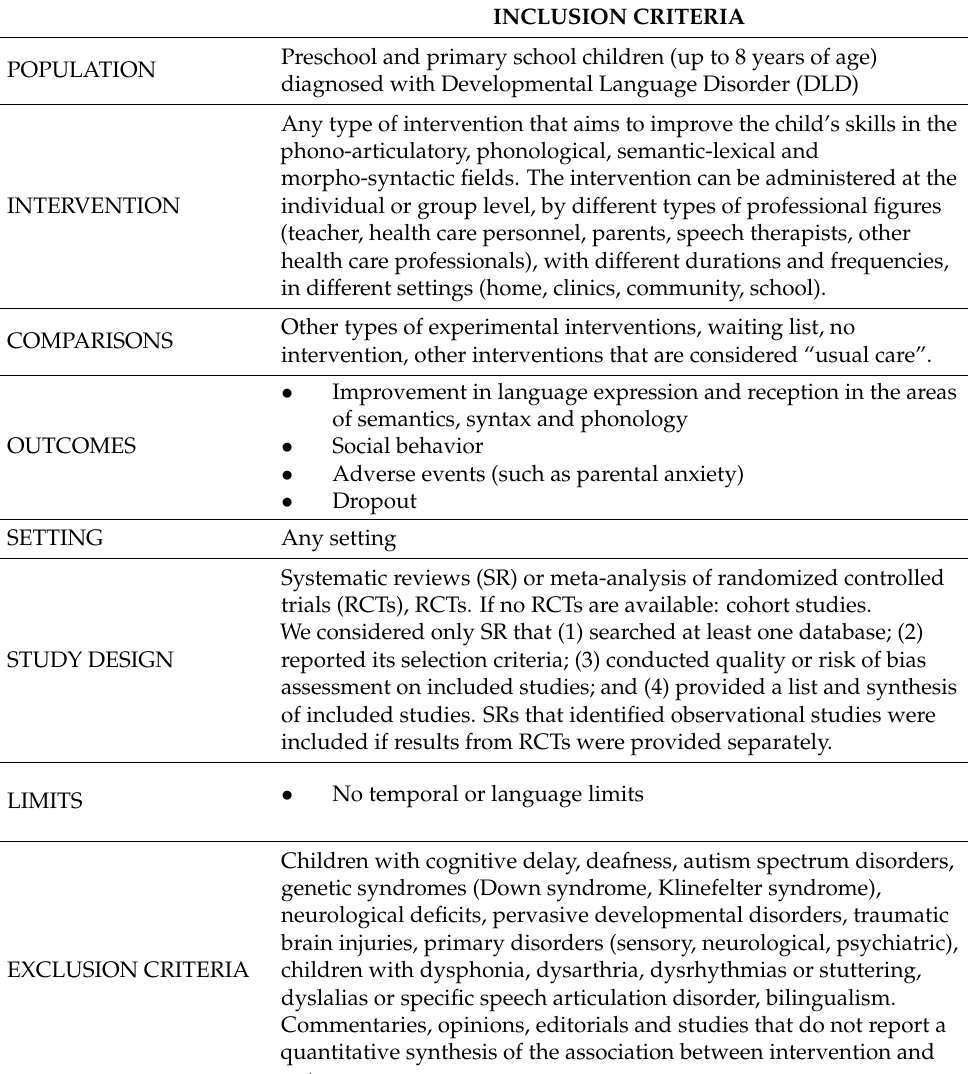
Table 1. Inclusion and exclusion